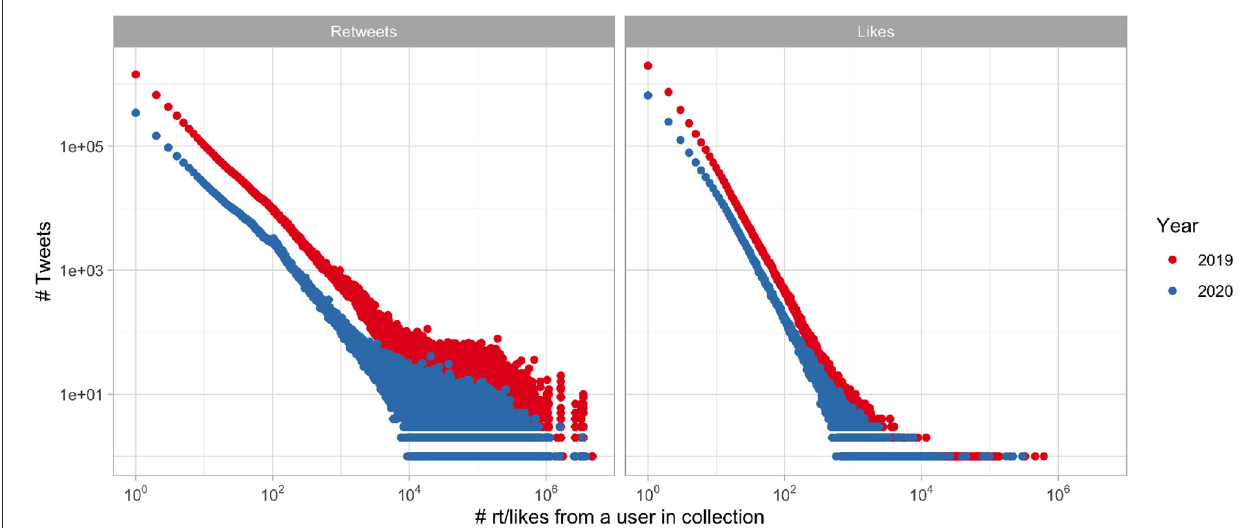
FIGURE 4 | Distribution of tweets having certain number of retweets (left) and likes (right), log scale.